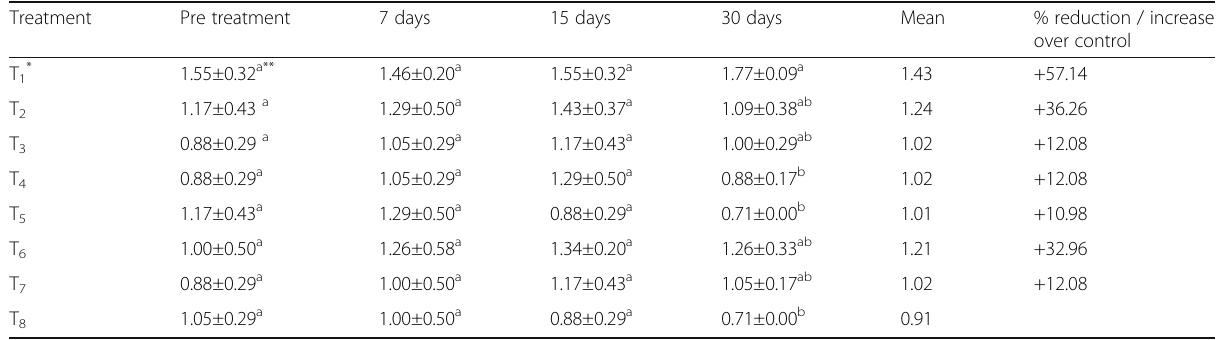
Table 4 Effect of insecticides on minute arthropods in soil at different intervals Treatment Pre treatment